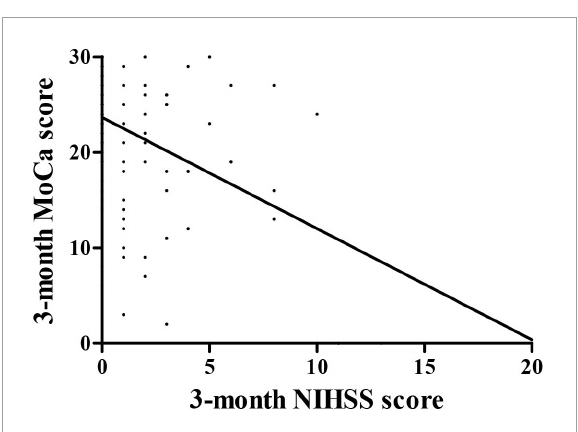
FIGURE2 Correlation between 3-month MoCa and NIHSS score.